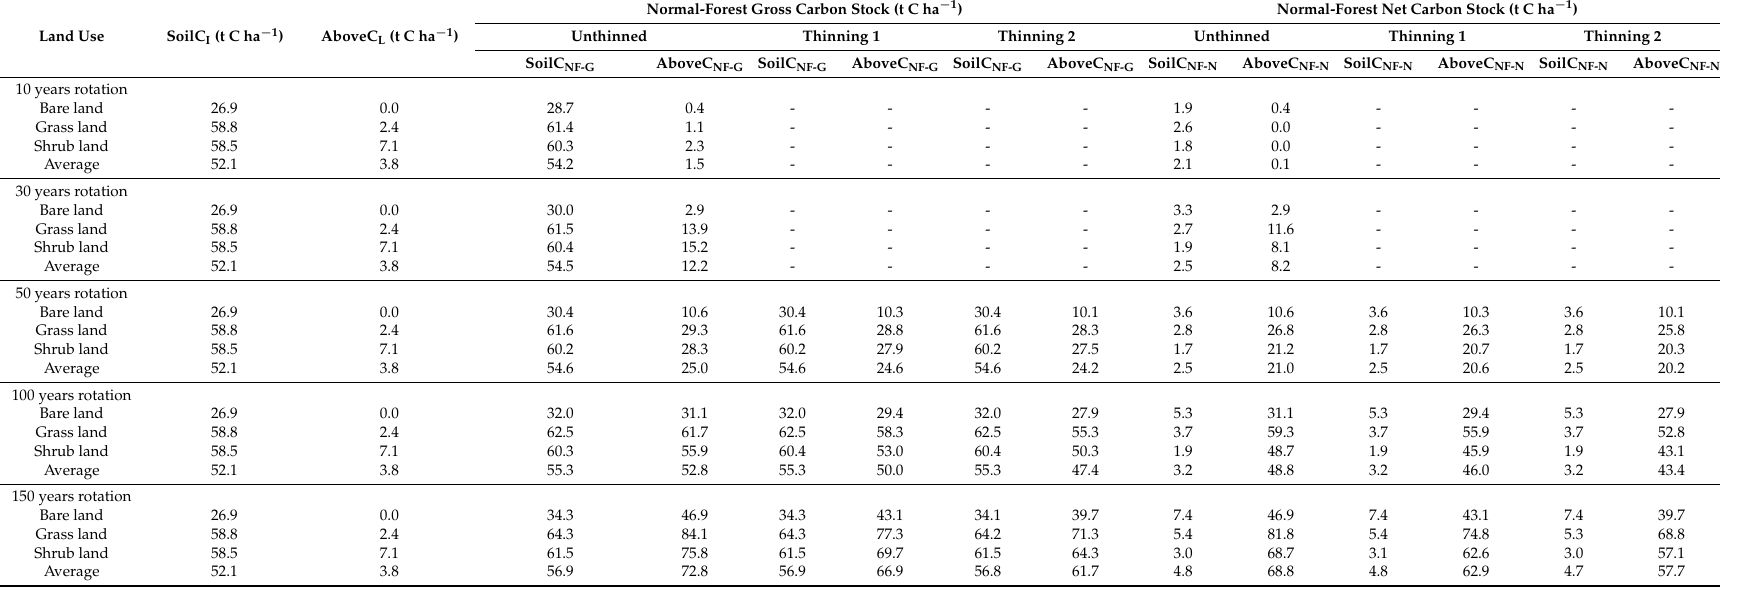
Table 5. Model predicted carbon sequestration potential through reforestation for different ‘Normal-forest’ rotations periods (10, 30, 50, 100, and 150 years) in different land use types and under different managements. Initial soil carbon (SoilC I ) and aboveground carbon (AboveC L ) are obtained as described in Table 1. All carbon values are in (t C ha − 1 ). Since, according to our management scenarios, no management is applied in the first two rotation period options (10 and 30, see Section 3.3), we present only ‘Unthinned’ in the first two rotation period